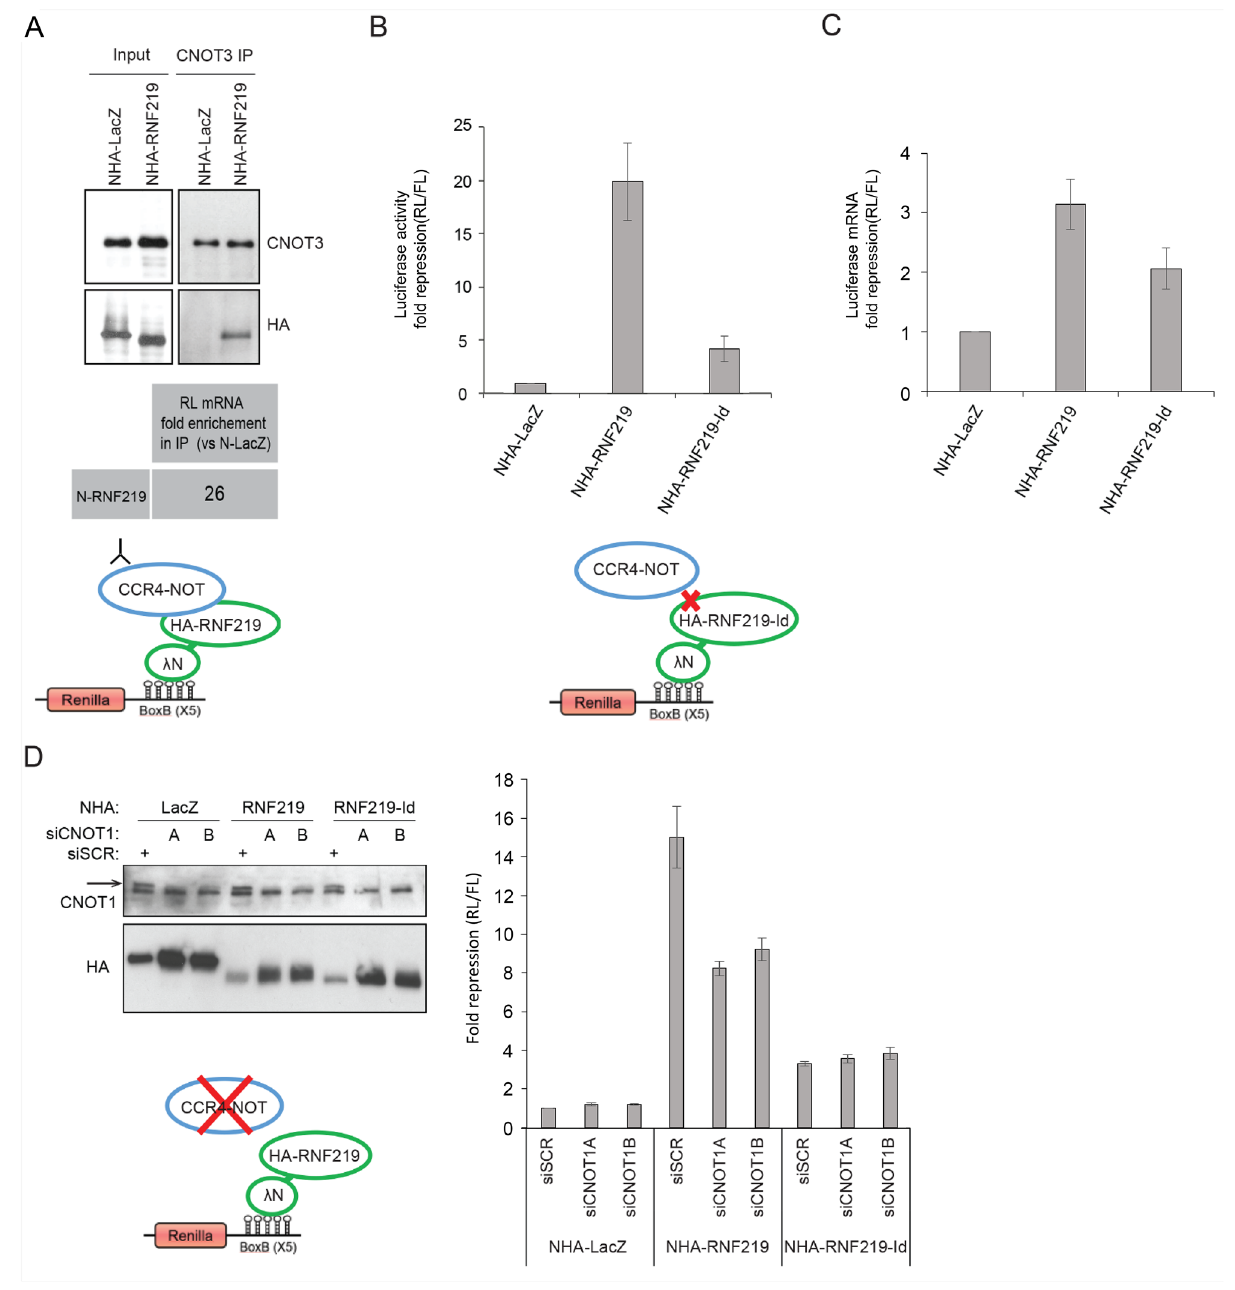
Figure 4. RNF219 mediated translational repression is CCR4-NOT dependent. ( A ) CNOT3 interacts with RNF219 tethered to the mRNA reporter. RNA-IPs were performed on extracts of cells transfected with the RL reporter and NHA-LacZ or NHA-RNF219 using CNOT3 antibody. The level of Renilla mRNA in the CNOT3-IP was highly enriched in NHA-RNF219 transfected cells as compared to NHA-LacZ transfected cells, as quantified by RTPCR. Results representative of two replicates are shown. ( B ) RNF219 interaction with the CCR4-NOT complex is necessary for RFN219 to repress RL reporter translation efficiently. (Top) RL activity was determined in the indicated conditions (NHA-LacZ, NHA-RNF219 and NHA-RNF219-Id). RL activity repression was determined as in Fig. 3B. Error bars represent SD, n = 3. (Bottom) Protein levels of NHA-LacZ, NHA-RNF219, NHA-RNF219-Id in HeLa cells transfected with the corresponding plasmids were analyzed by immunoblotting. ( C ) mRNA levels of samples in ( B ) were quantified as in Fig. 3D. Error bars represent SD, n = 3. ( D ) Knock down of CCR4-NOT scaffold CNOT1 affects NHA-RNF219 mediated repression. RL activity was determined in the indicated conditions (NHA-LacZ, NHA-RNF219 and NHA-RNF219-Id) in control cells (siSCR) or in siCNOT1 depleted cells (siCNOT1A and siCNOT1B are two siRNA targeting different regions of CNOT1 mRNA). (Right) RL activity repression was determined as in Fig. 3B. RL repression levels are relative to that of the control NHA-LacZ in the siSCR cells, set to 1. Error bars represent SD, n = 3. (Left) Protein levels. The arrow indicates the expected CNOT1 band. The lower is a non-specific band as it does not disappear in siCNOT1 treated